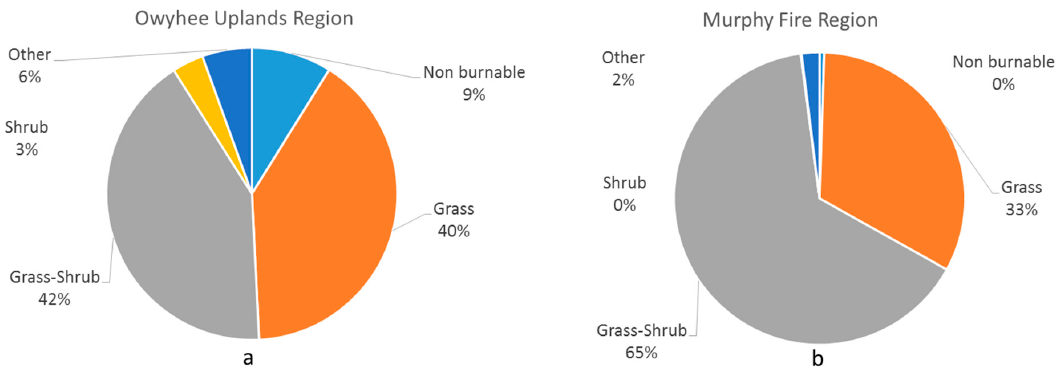
Figure 1. The LANDFIRE program fuel types in the Owyhee Uplands and Twin Falls regions (purple boundary), Monitoring Trends in Burn Severity (MTBS)-recorded fire history from 2001 to 2010 (blue boundaries), and the boundary of 2007 Murphy fire (red boundary).